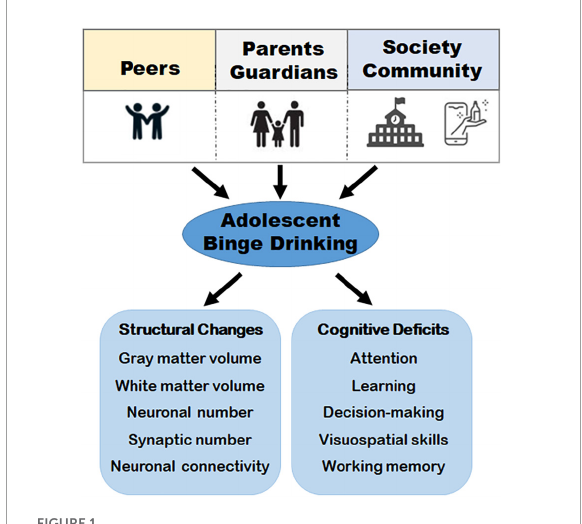
FIGURE1 A schematic representation of major factors that contribute to binge drinking and the downstream consequences. Social factors such as peers and social acceptance, family and parental guidance, and the community, combined with internal factors, such as, age, sex hormones, and psychological status can influence binge drinking during adolescence. Binge drinking (i.e., consuming 4 ≥ standard drinks for women and 5 ≥ standard drinks for men in a brief period of time) usually within 2 h, contributes to structural changes such as decreased gray matter volume and white matter density, changes in synaptic number, neuronal loss, and disruption of brain connectivity. These structural changes have been implicated in cognitive deficits such as altered working memory, attention, visuospatial skills, decision-making, and learning deficits in adolescent binge drinkers and young